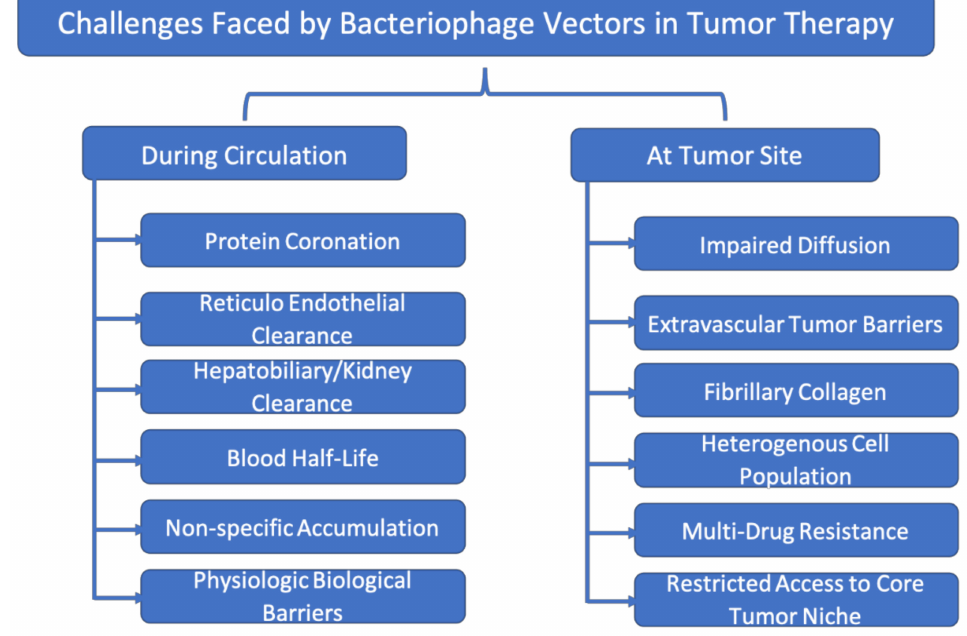
Figure 2. Challenges faced by cancer therapeutic bacteriophage vectors in biological